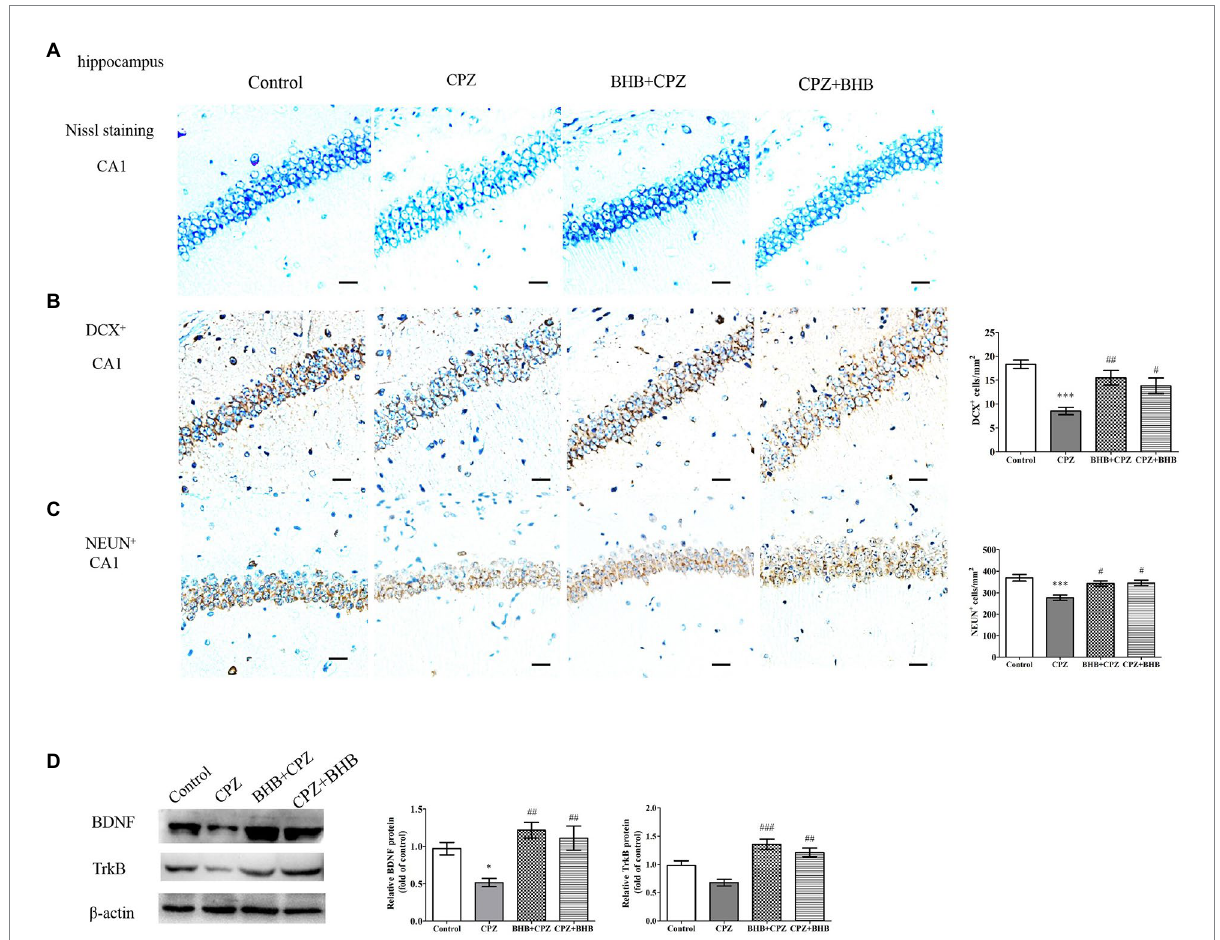
FIGURE 9 Histological images of the hippocampus and WB analysis of expression of BDNF and TrkB. (A) Nissl staining of the CA1 in the hippocampus in different treated groups. Distribution of immunoreactive cells for (B) DCX + and (C) NeuN + in the hippocampal CA1 of mice after CPZ exposure. The histograms show the number of immunoreactive cells in the different groups. (D) Representative WB of BDNF, TrkB and β -actin in hippocampal protein samples and semi-quantitative analysis of WB results; β -actin served as loading control. Bars = 25 μ m. Data are presented as mean ± SEM. N = 3 per experimental group; experiment repeated two times. * p < 0.05 and *** p < 0.001 versus the control group; # p < 0.05, ## p < 0.01, and ### p < 0.01 versus the CPZ